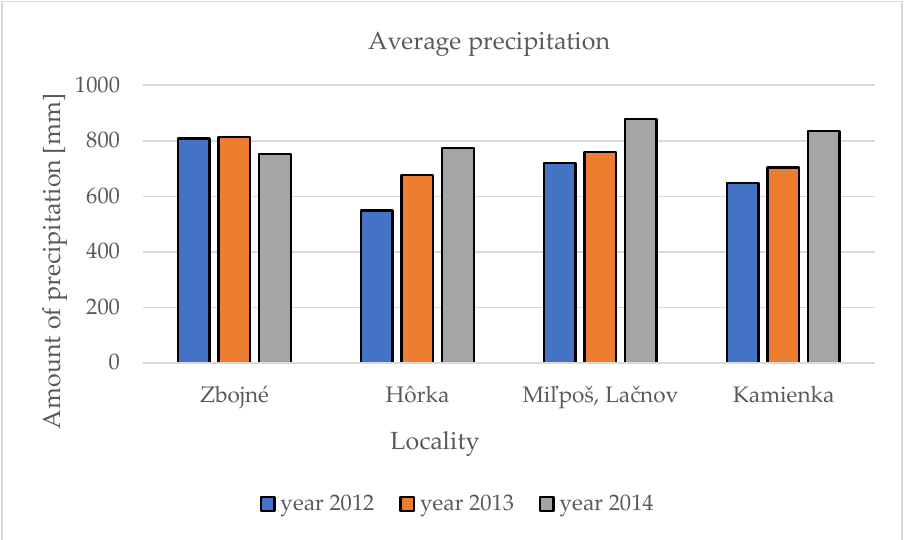
Figure 1. Average amount of the precipitation in five localities during three observation years.